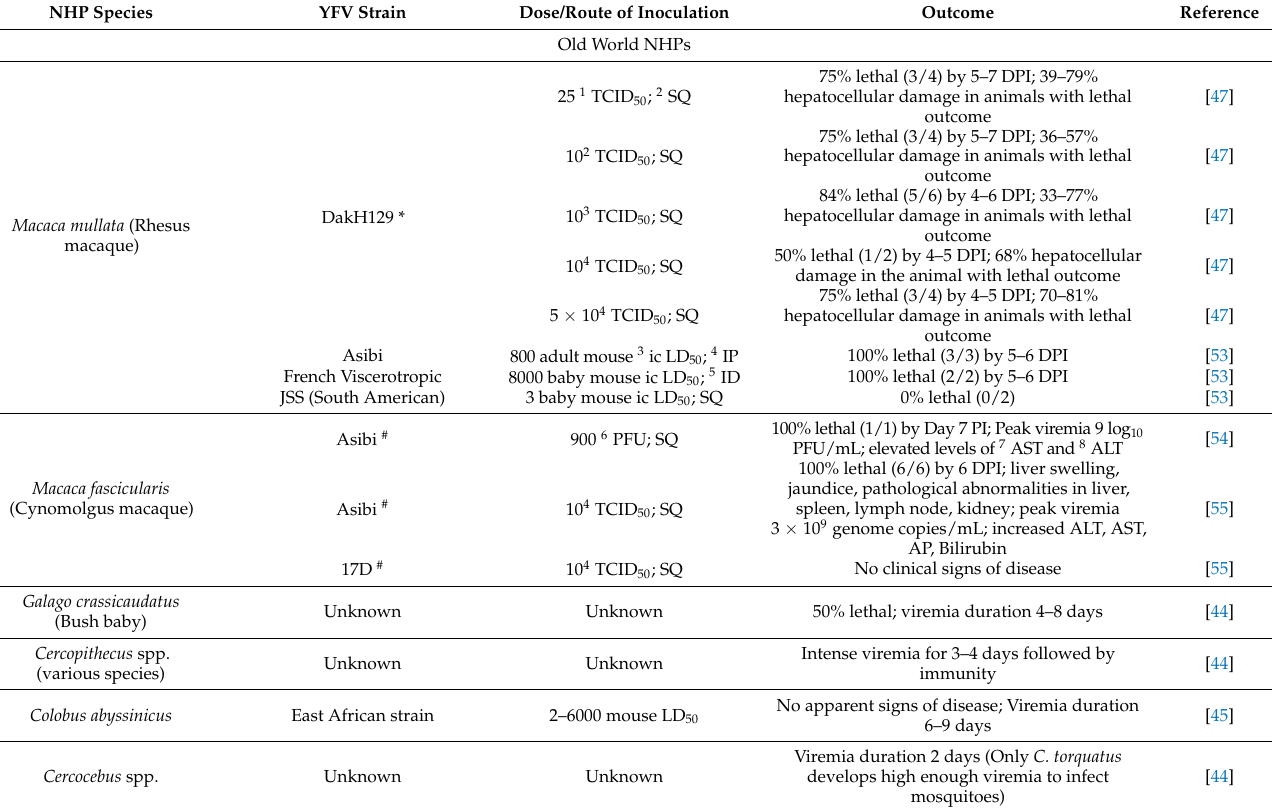
Table 2. NHP models of YFV